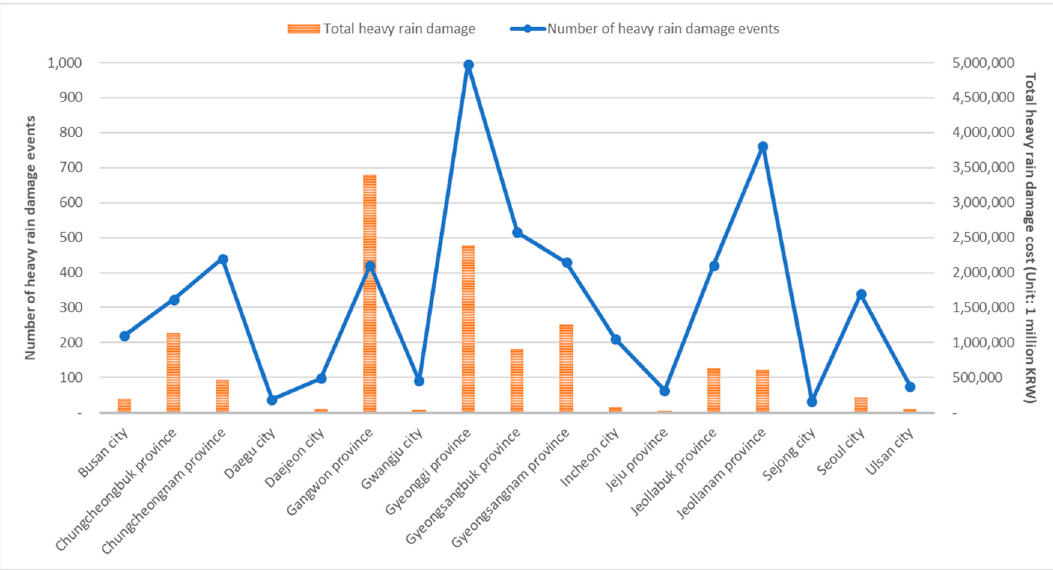
Figure 1. Number of heavy rain damage events and total heavy rain damage (1988–2017).